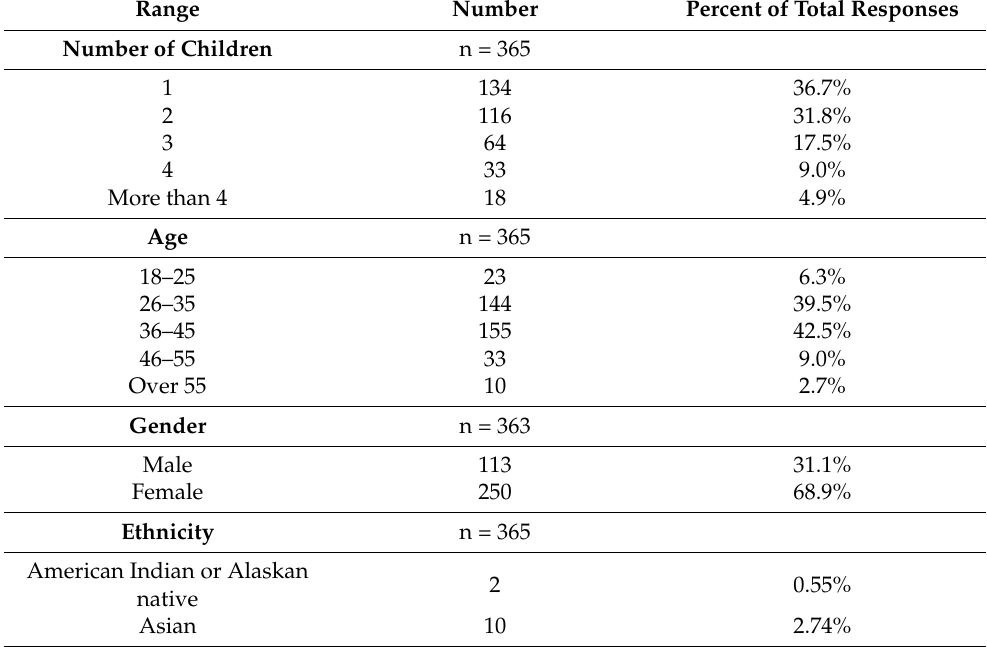
Table 1. Demographic